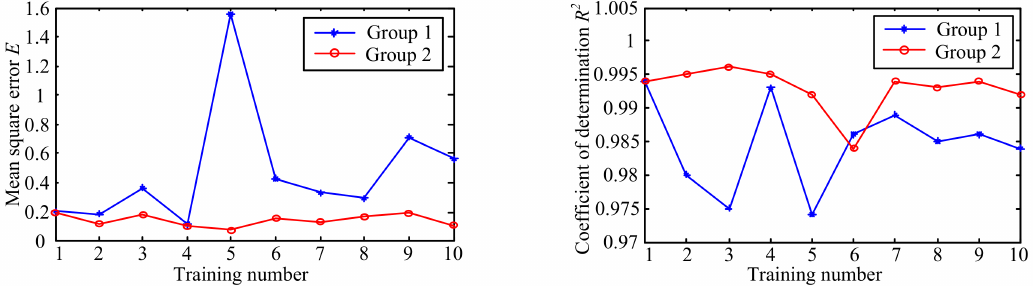
Figure 10. Model performance comparisons of two groups of characteristic